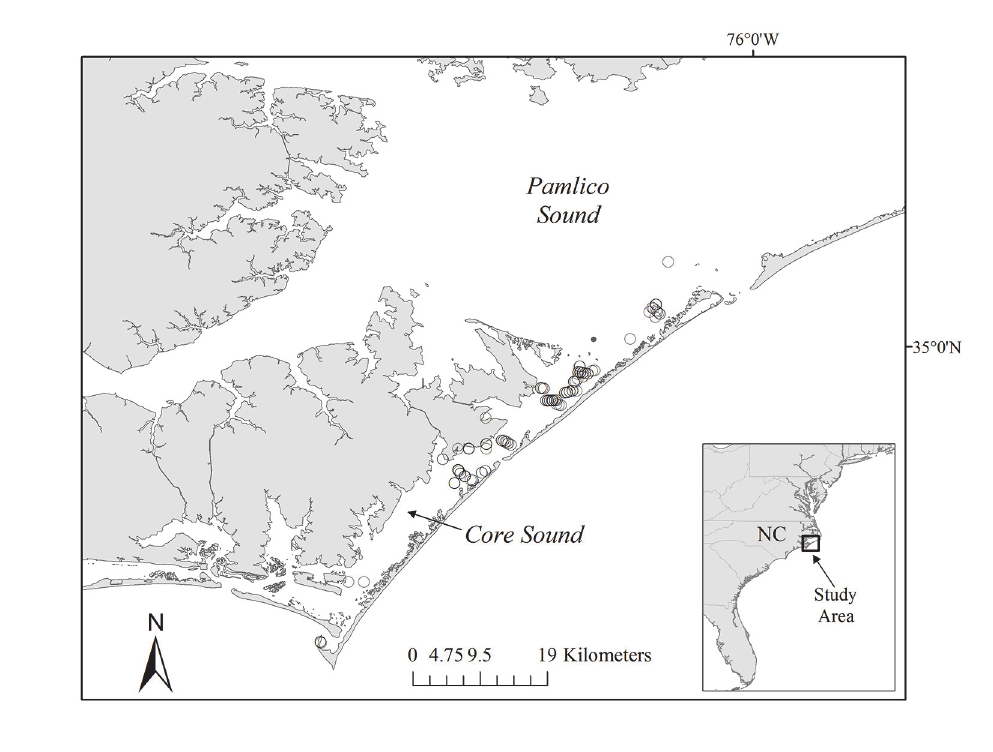
Fig 1. Capture sites within Core Sound, North Carolina where juvenile loggerhead sea turtles were sampled to estimate hematologic and biochemical reference intervals for this population.